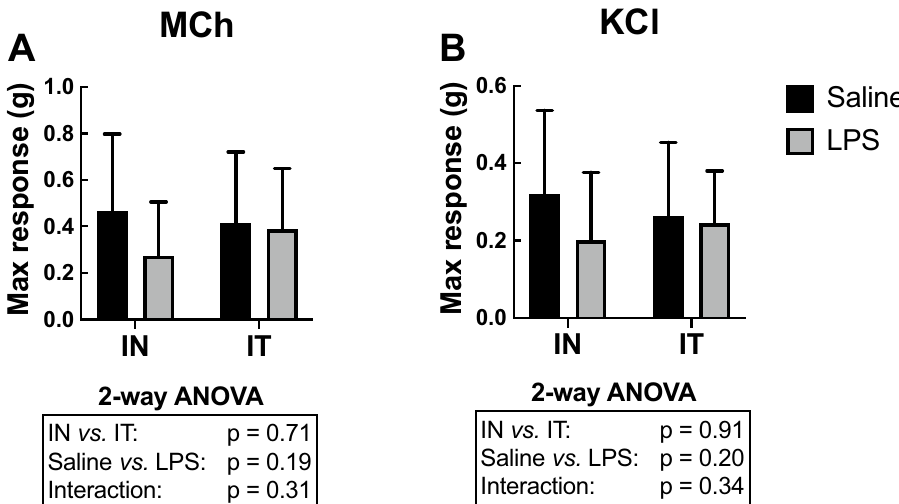
Figure 7. Contractility of excised tracheas. The maximal force generated by excised tracheas in response to ( A ) a cumulative concentration of methacholine (MCh) ending with 10 –4 M or ( B ) a cumulative concentration of potassium chloride (KCl) ending with 160 mM are depicted for mice treated in vivo with either saline (black) or LPS (grey) through either the intranasal (IN) or the intratracheal (IT) route. The results of the two-way ANOVA are shown at the bottom of each graph. n = 12 per group and the data shown are means ±